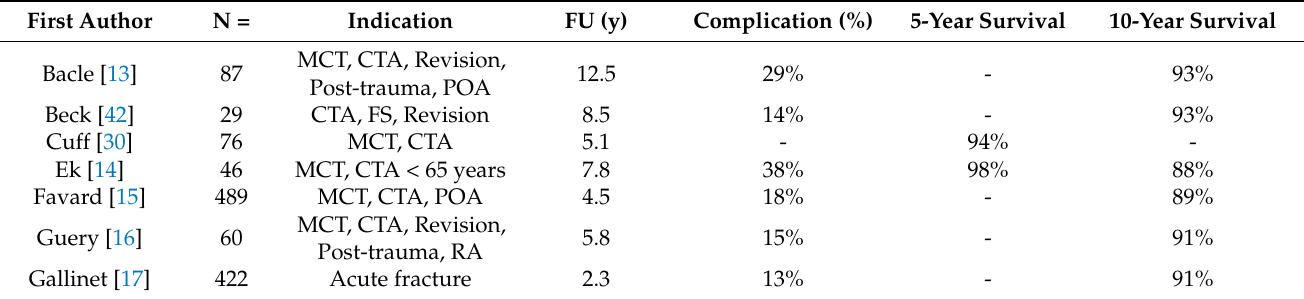
Table 7. Mid-term and long-term survivals of reverse shoulder arthroplasty reported in the